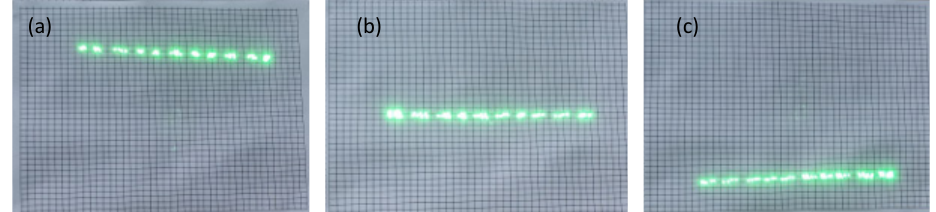
Figure 12. Scanning projection effect: ( a ) distribution of scanning points in the top row; ( b ) distribu- tion of scanning points in the middle row; ( c ) distribution of scanning points in the bottom row.